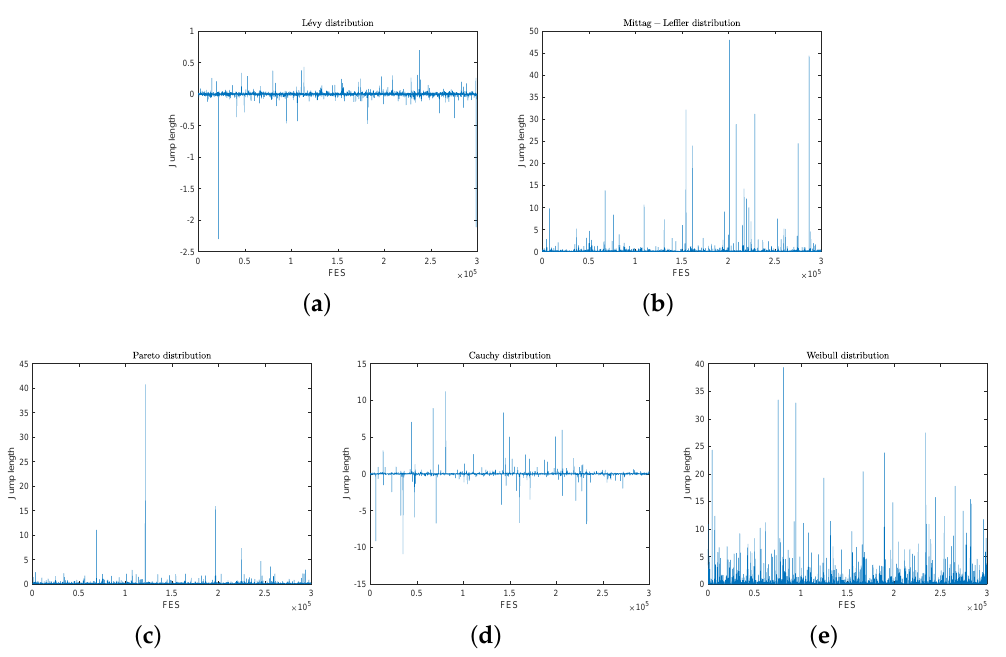
Figure 3. Jump lengths of CS, CSML, CSP, CSC and CSW. ( a ) Lévy distribution of CS. ( b ) Mittag-Leffler distribution of CSML. ( c ) Pareto distribution of CSP. ( d ) Cauchy distribution of CSC. ( e ) Weibull distribution of